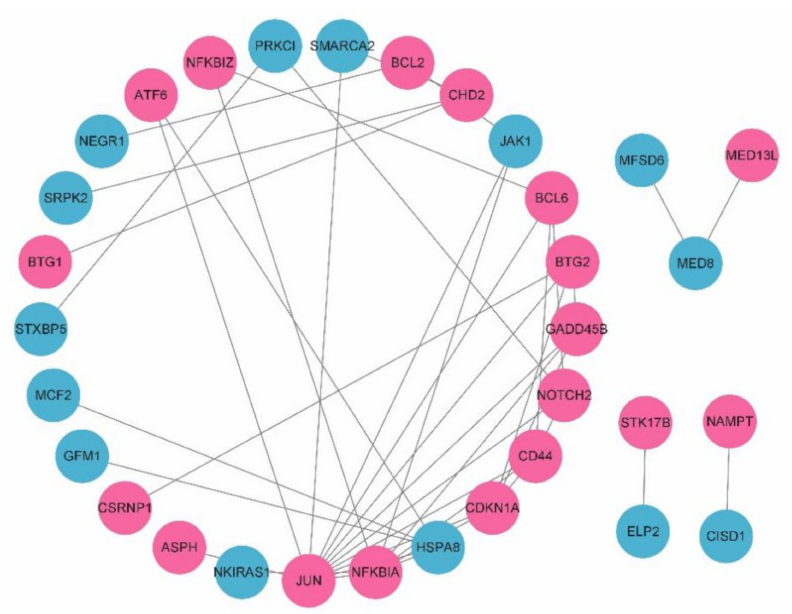
Figure 5. Protein–protein interaction network constructed with the DEGs. Red nodes represent upregulated genes, and blue nodes represent downregulated